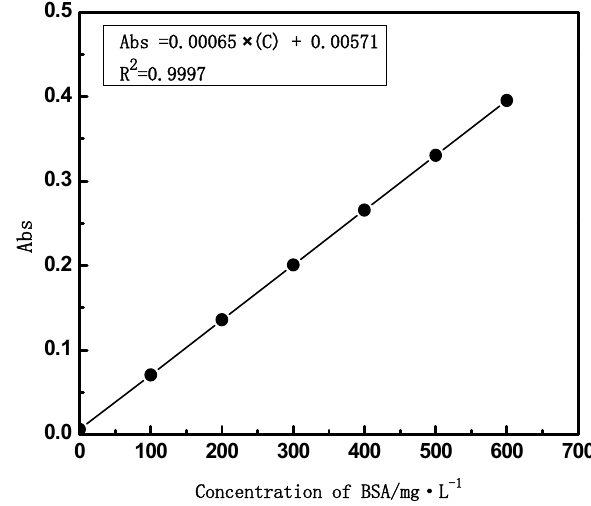
Figure 4. The standard curve of BSA. The concentrations of BSA are measured with a UV-Vis spectrophotometer (TU-1810, Purkinje, Beijing,